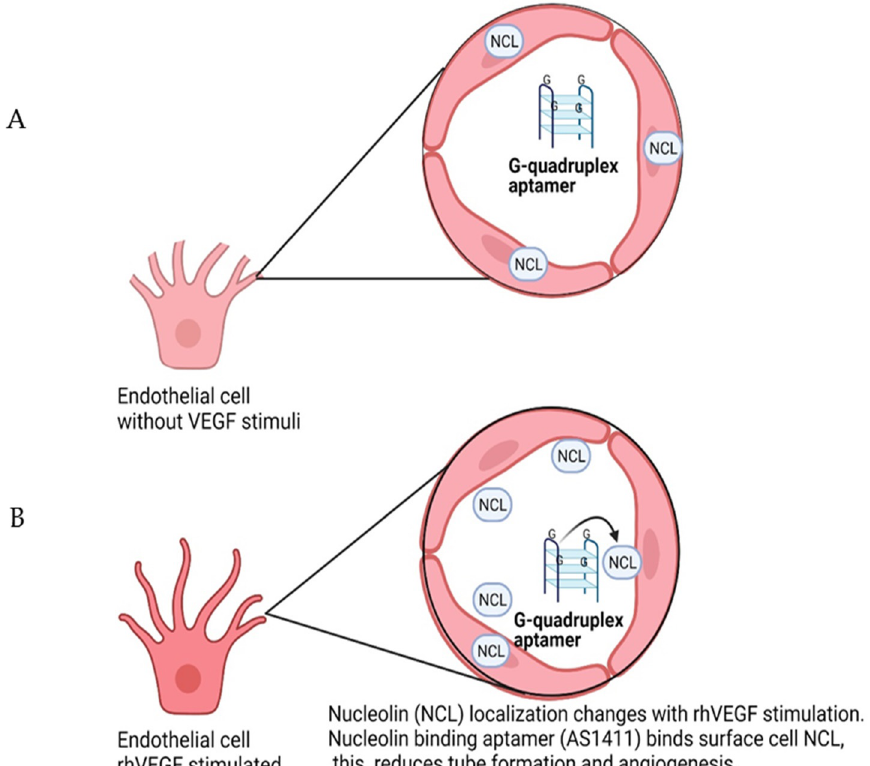
Figure 2. Nucleolin localization changes with rhVEGF in endothelial cells. ( A ) NCL is a protein mainly found in the nucleolus, but it can also be translocated to the cell surface by rhVEGF stimulation, therefore, nucleolin is not located on the cell surface of quiescent blood vessels, only in angiogenic vessels. ( B ) Huang. et al. demonstrated that rhVEGF, extracellular matrix, and the intracellular protein MyH9 are vital to mobilize NCL to endothelial cell surface membrane and therefore act as a proangiogenic factor [158]. Previous studies published by Darche et al. showed that retinal endothelial tip cells had NCL in surface membrane and demonstrated that intraperitoneal administration of a potential antagonist to NCL called N6L reduced retinal tuft in 50 % [159]. Created with BioRender.com.